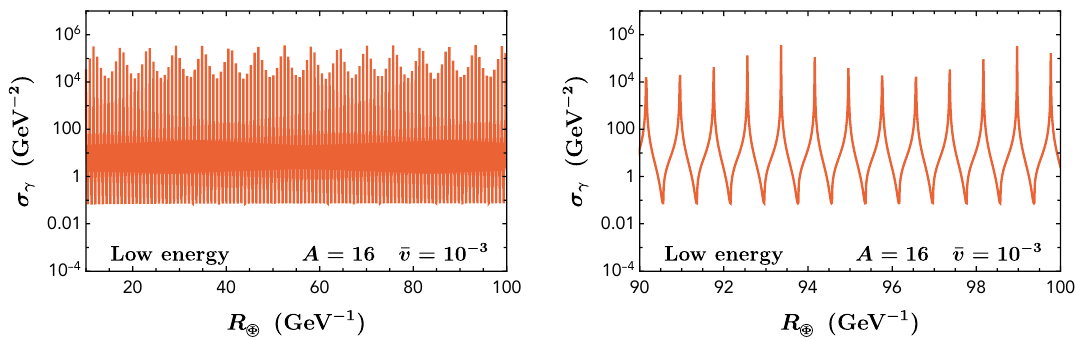
Figure 4 . Radiative capture cross section as a function of the DMB radius for Z = 8, A = 16, V 0 = A (cid:2) 32 MeV, and (cid:22) v = 10 (cid:0) 3 in the low energy limit, in which only s -wave scattering state is included. The right panel narrows the range to the largest radii